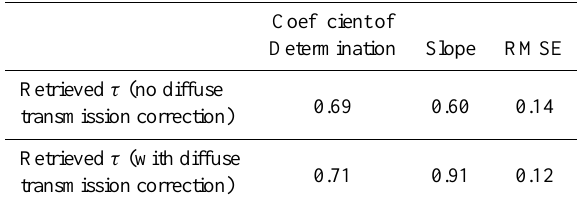
Table 2. Coefficient of determination, slope, and RMSE values obtained by comparing the retrievals from Eq. (7) to average AERONET τ values taken from before and after the VIIRS satellite overpass. Results are shown for the case where no diffuse transmis- sion correction is applied ( k in Eq. 7 set to 1), and the case where the 6s urban aerosol model is used for Grand Forks, the desert model is used for Cape Verde, and the biomass burning model is used for Alta Floresta.